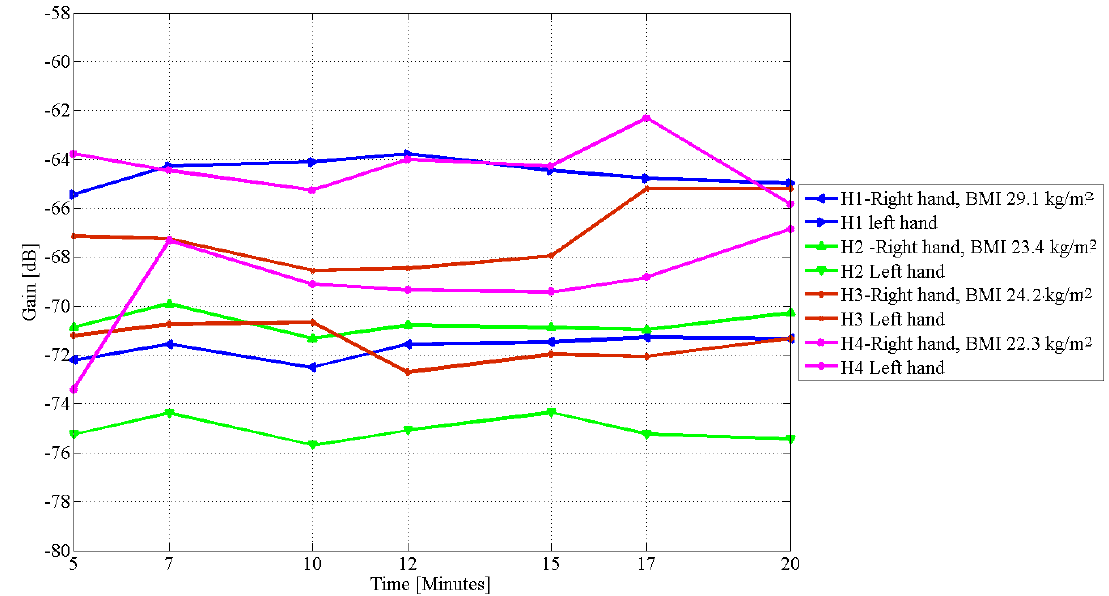
Figure 6. Measurement of galvanic coupled signal gain at 900 kHz, after fluid restriction and intake of 350 mL, on both arms of healthy subjects.